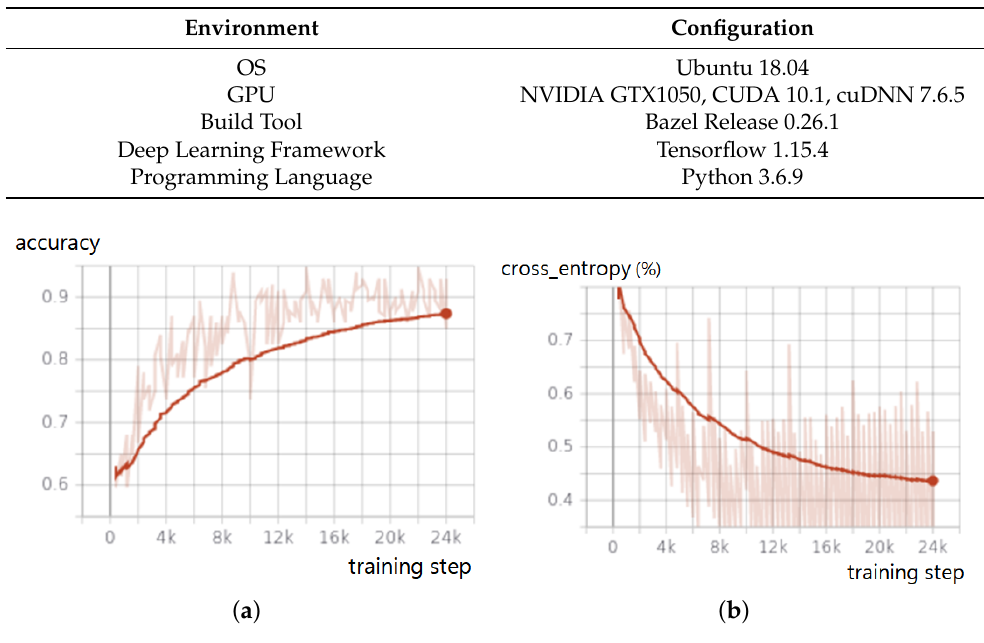
Table 3. Training environment.